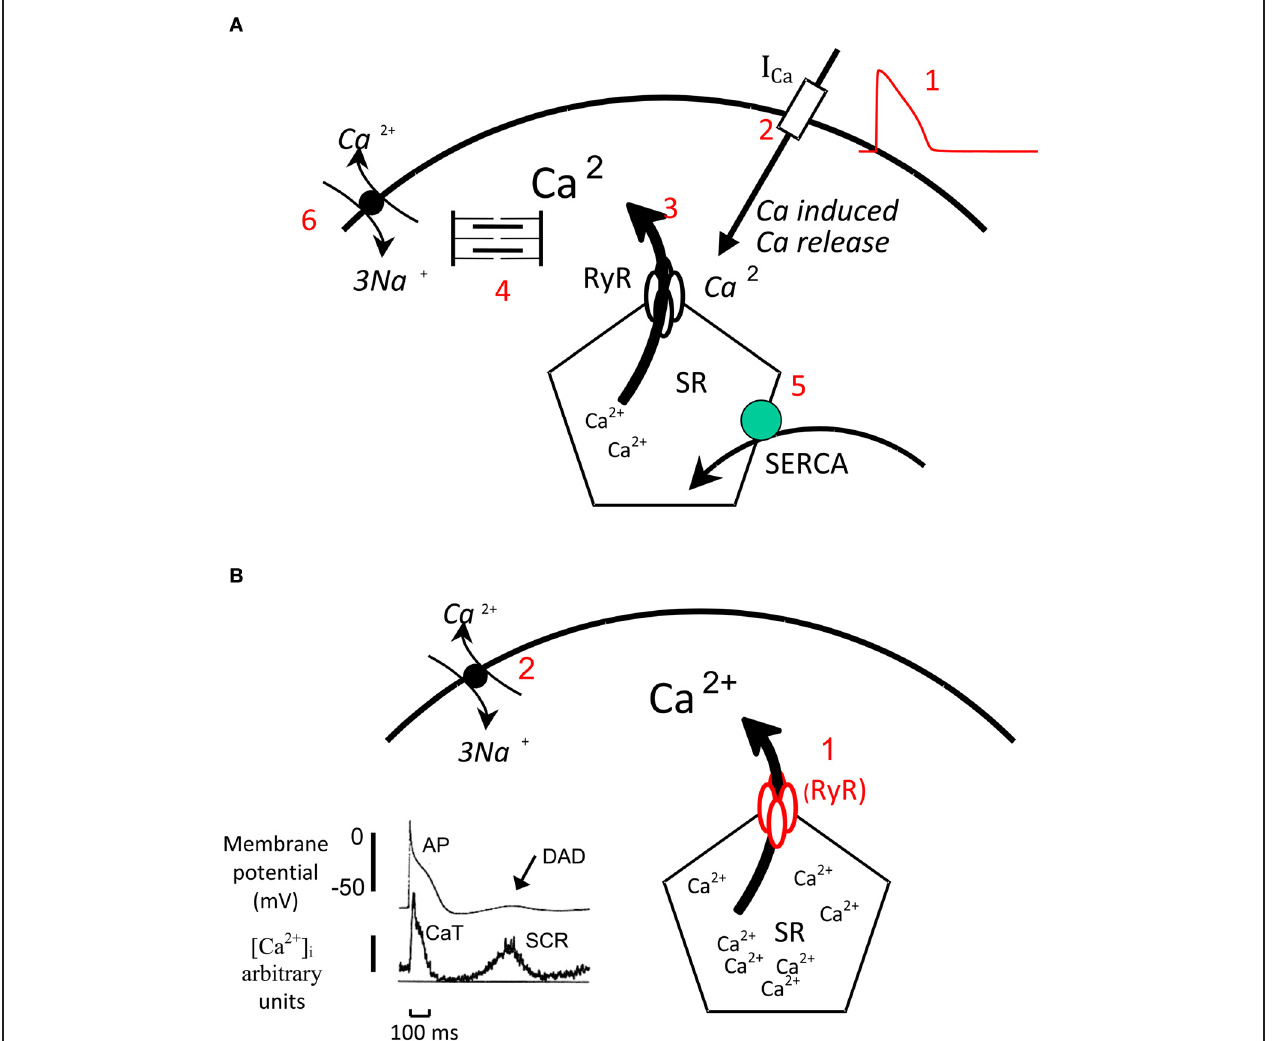
(B) Generation of SCR and DADs: When intra SR calcium concentration is very high the SR can release calcium (1) independently from an AP this process is called spontaneous calcium release (SCR). This calcium activates the NCX (2) that generates an inward current and produces a delayed after—depolarization (DAD). The record on the left shows simultaneous recording of membrane potential and cytosolic calcium levels. The AP is triggers the calcium transient (CaT) while during diastole a SCR triggers a